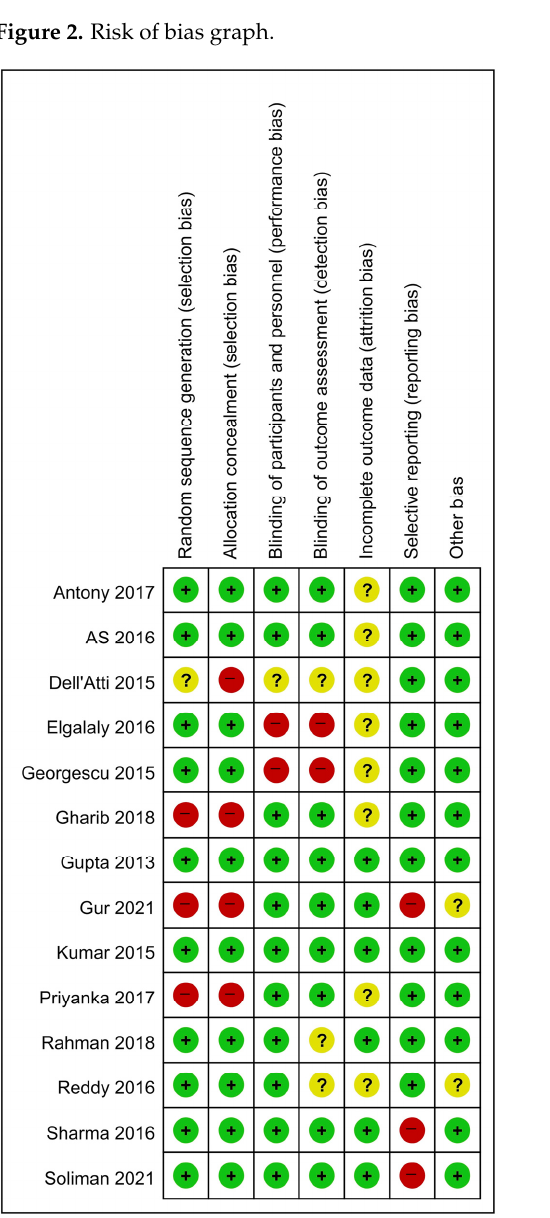
Figure 3. Risk of bias summary.